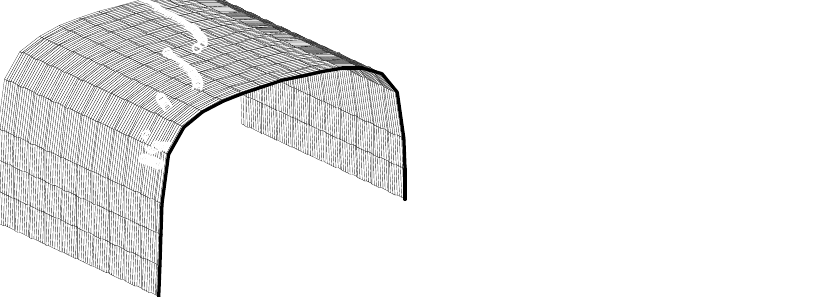
Figure 6. The position of contact points on the surface of a rail (rail inclination 1:40).